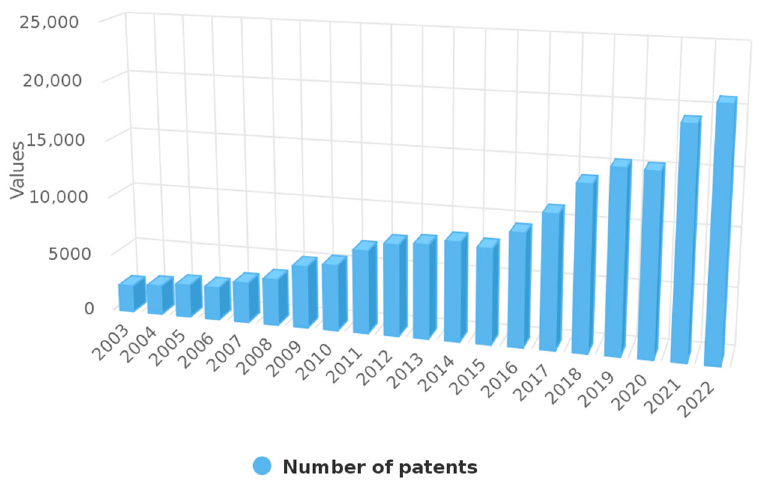
Figure 2. Changes in the number of CCUS patents over years.